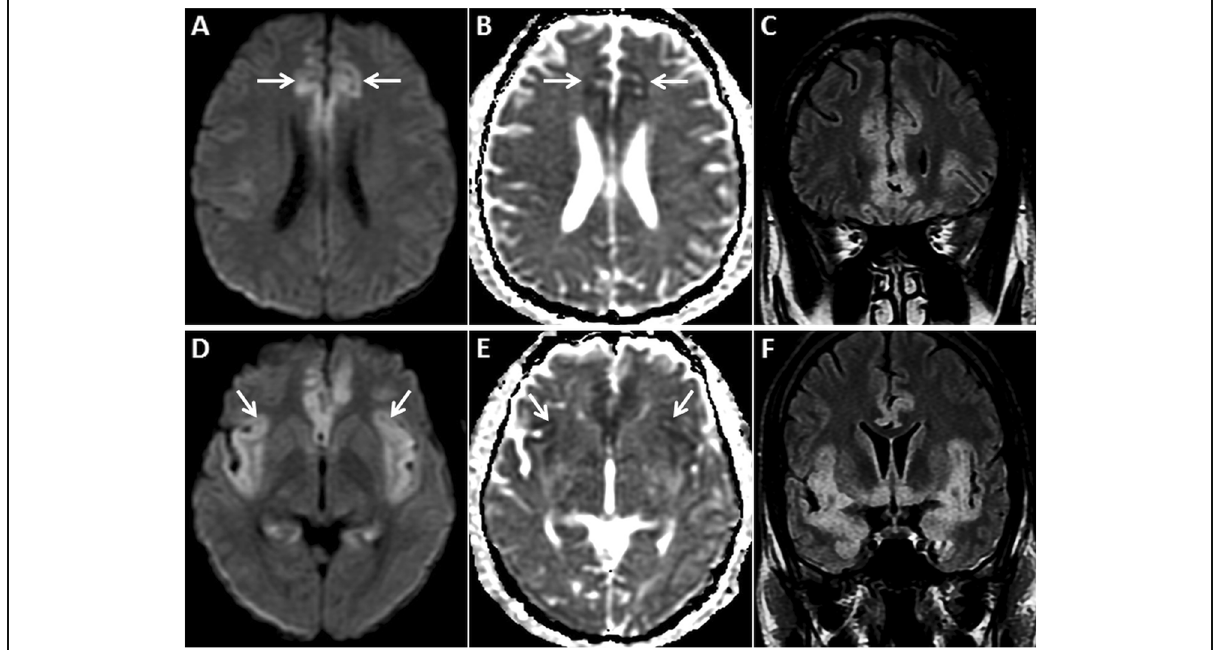
Fig 6 MRI of the brain in a 26-year-old female patient brought unconscious following valproate overdose. Symmetric GRD is seen in the cingulate gyri (arrows) on axial DWI ( a ) and ADC image ( b ). GRD is also seen in the insular cortices (arrows) on axial DWI ( d ) and ADC image ( e ). Coronal FLAIR images ( c , f ) reveal hyperintense cortical swelling in these regions, along with similar signal changes in bilateral mesial temporal lobes. Laboratory tests confirmed the diagnosis of